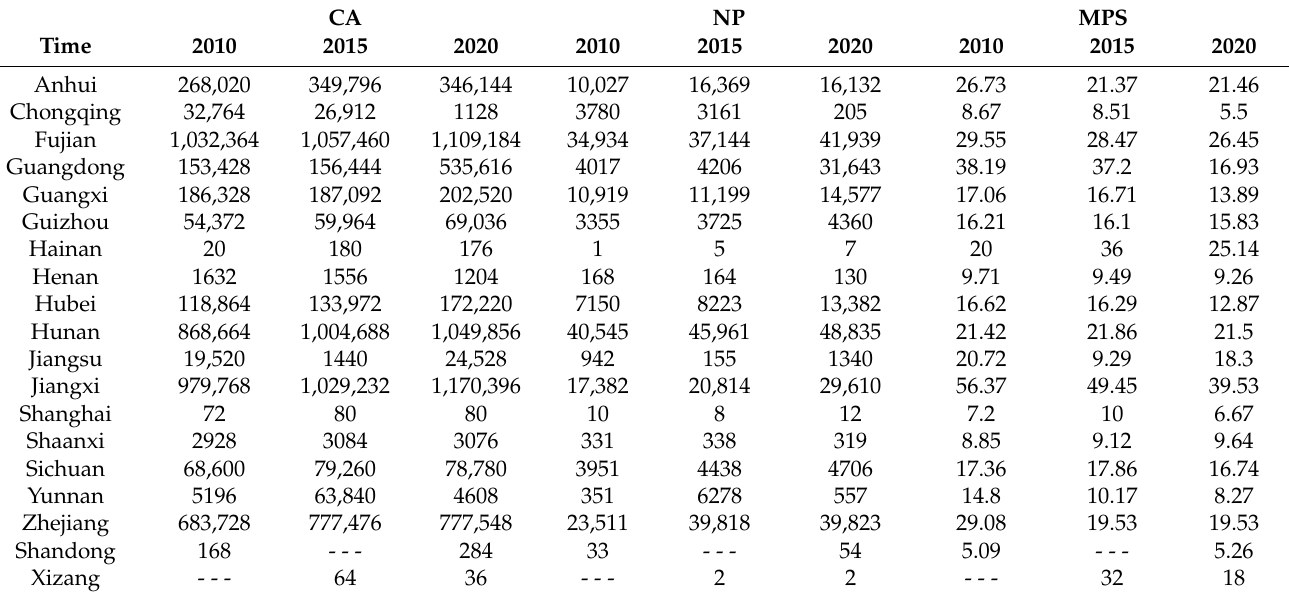
Table 3. Changes in CA, NP, and MPS indices of moso bamboo forests in each province. CA NP